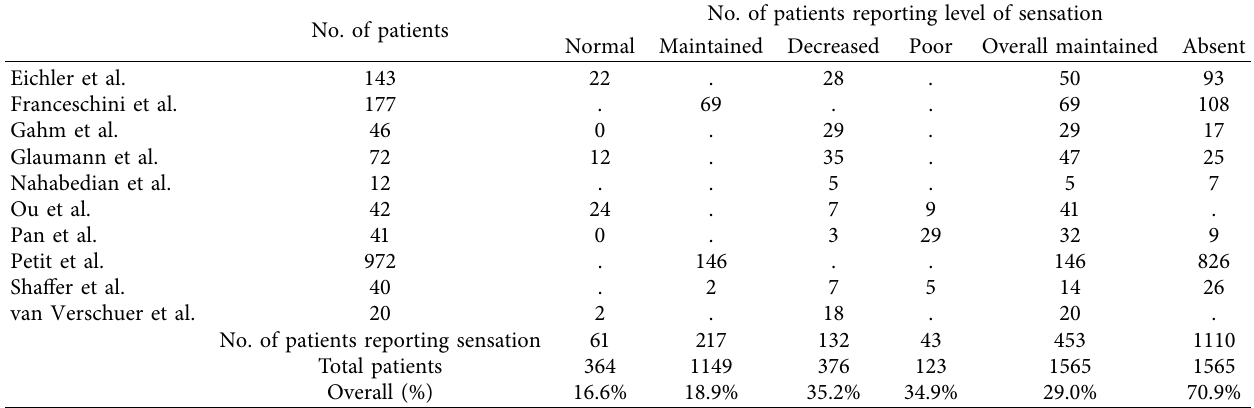
Table 4: Patient reported